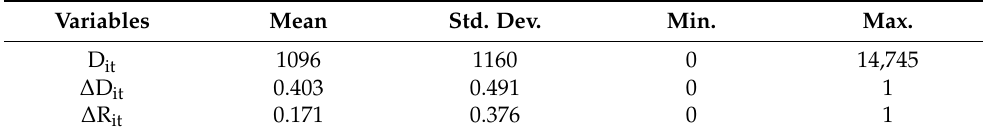
Table 2. Change in crime distance and change in risk level.